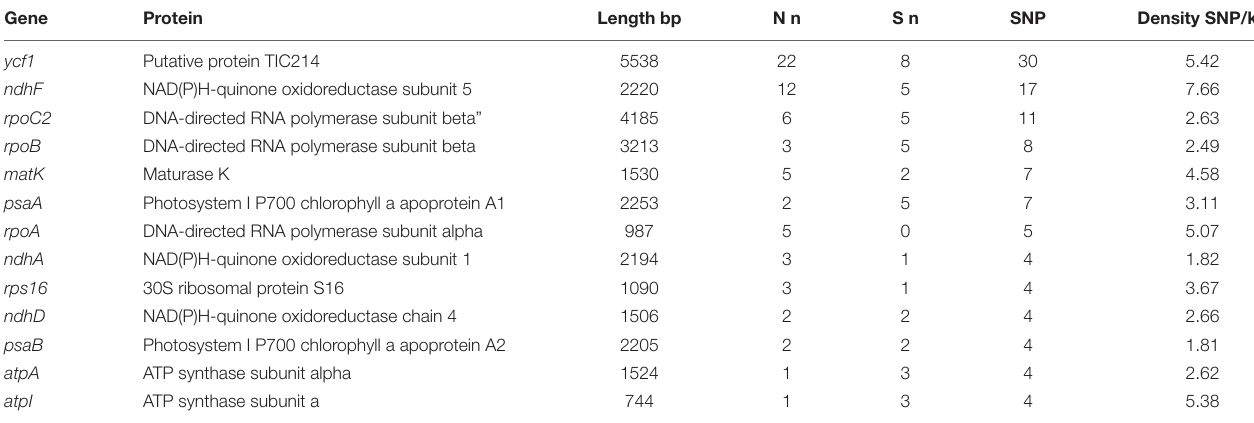
TABLE 2 | Highly variable Macadamia integrifolia chloroplast protein coding genes. Gene Protein Length bp N